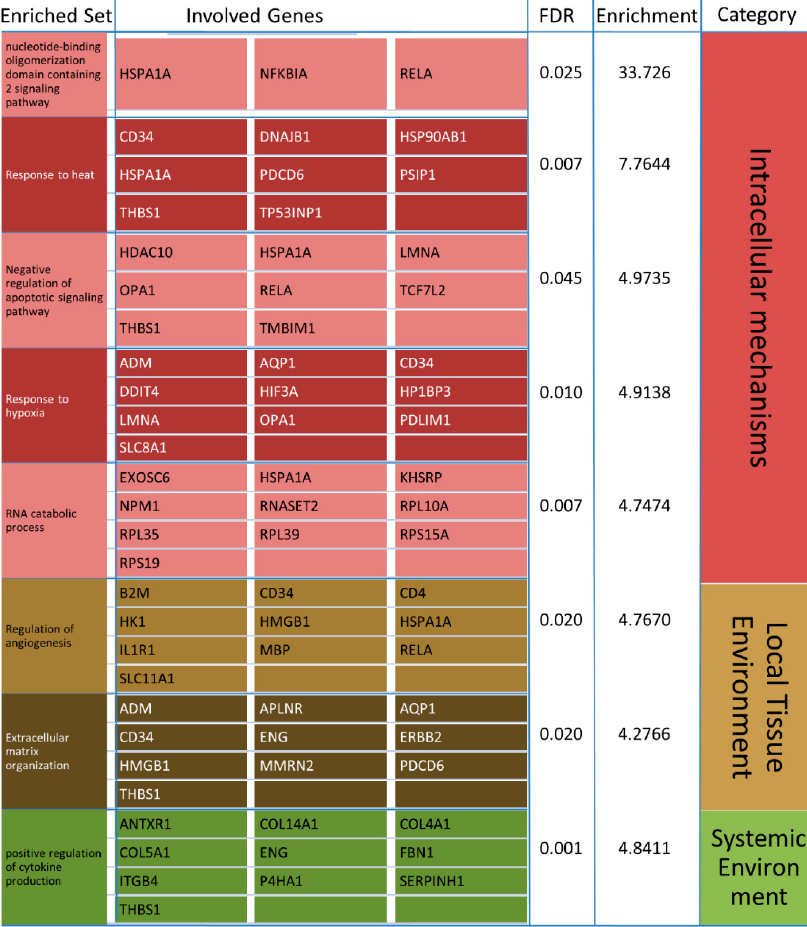
Figure 6. Significant results (FDR < 0.05) of the biological process (BP) GO-Term analysis for the transcriptomic overlap in the four analyzed NDDs after performing affinity propagation. The names of the enriched sets are shown in the left column, followed by the contributing genes on their right.